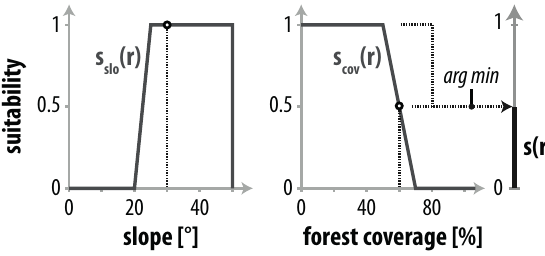
Figure 4. Suitability functions for slope s slo ( r ) and forest coverage s cov ( r ) . The minimum of the two indicates overall suitability s ( r ) , as indicated for the example location characterized by 30 ◦ slope steepness and 60% forest coverage.